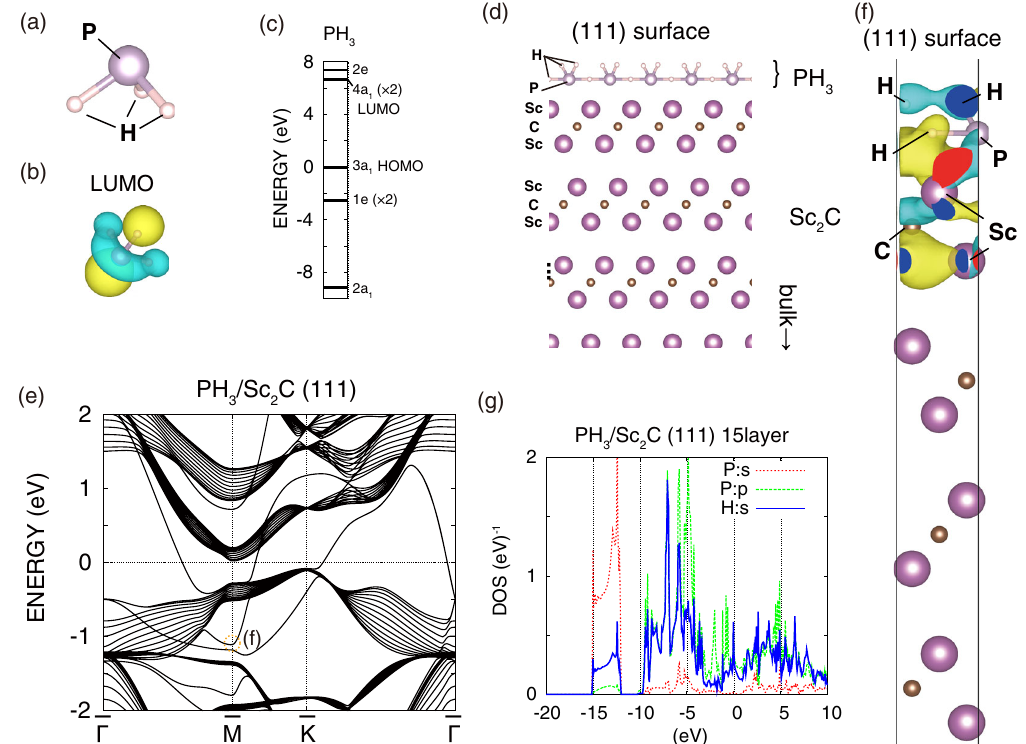
FIG. 9. PH 3 on Sc 2 C. (a) Molecular structure of PH 3 . (b) One of the lowest unoccupied molecular orbitals (LUMOs) of PH 3 . (c) Eigenenergy of PH 3 . (d) Crystal structure of PH 3 on the Sc 2 C (111) surface. (e) Electronic band structure of PH 3 on Sc 2 C. (f) Wave function of the eigenstate at the M point originating from PH 3 . The corresponding point is indicated by the dotted circle in (e). (g) Partial density of states (pDOS) of PH 3 on the 15 Sc 2 C layers. The energy is measured from the Fermi